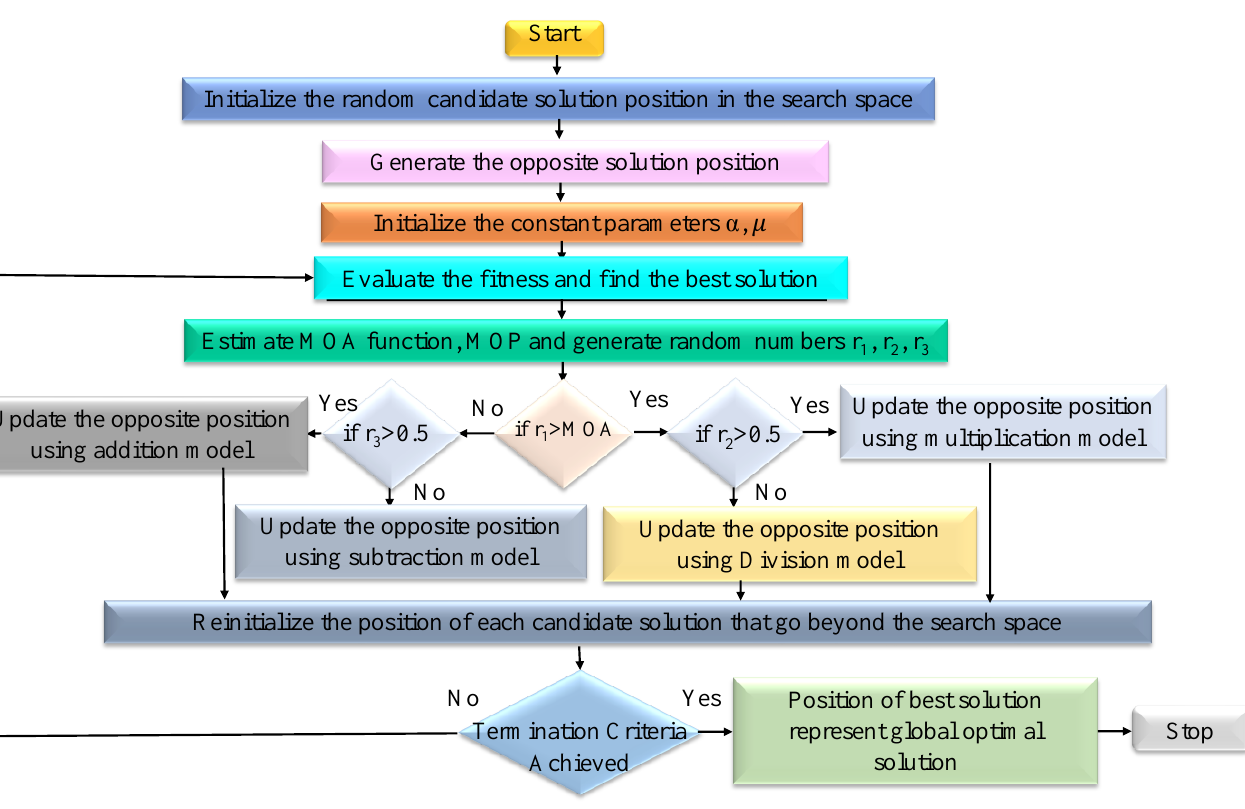
Figure 2. Flow chart of opposition-based arithmetic optimization algorithm.